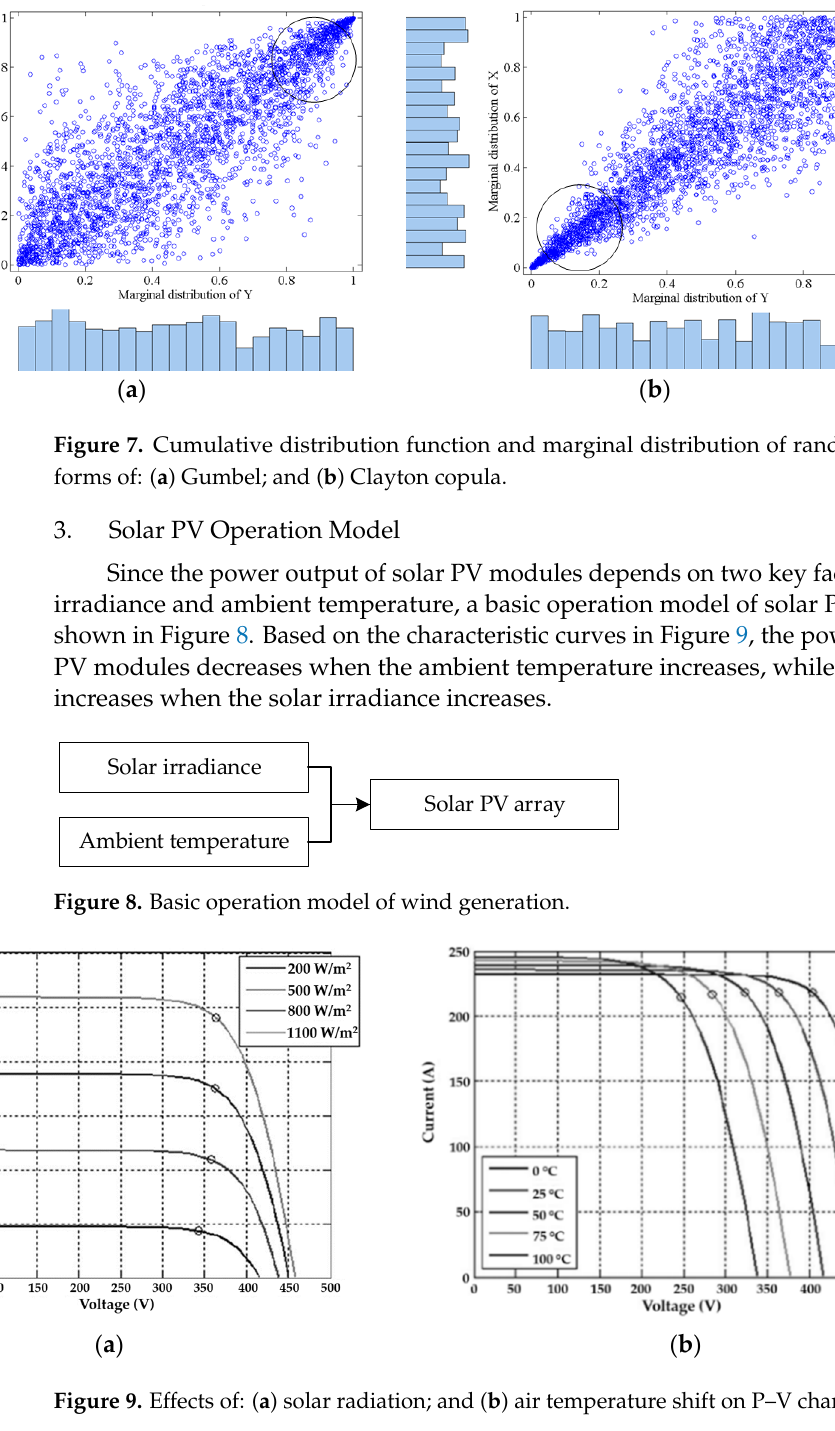
Figure 7. Cumulative distribution function and marginal distribution of random variables in the forms of: ( a ) Gumbel; and ( b ) Clayton copula.